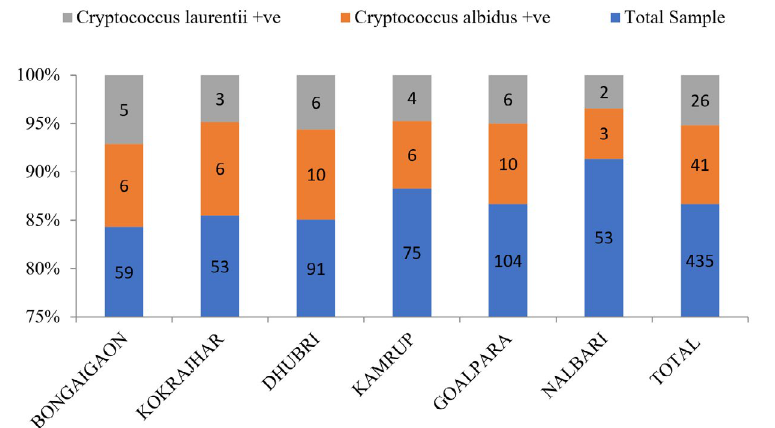
Fig. 11. District wise distribution of positive isolates of Cryptococcus